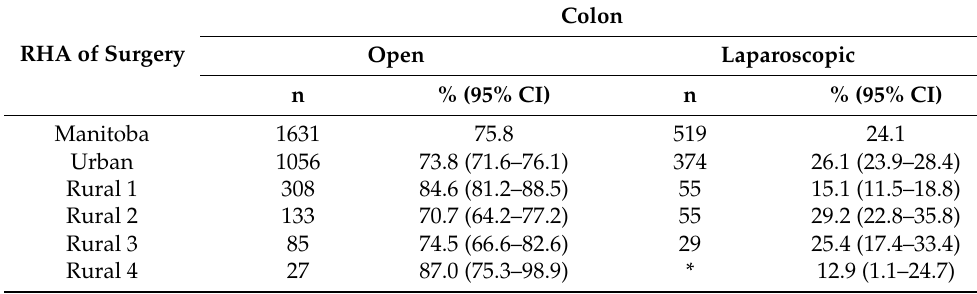
Table 2. Surgical Approach by Regional Health Authority of Surgery for Colon Cancers,